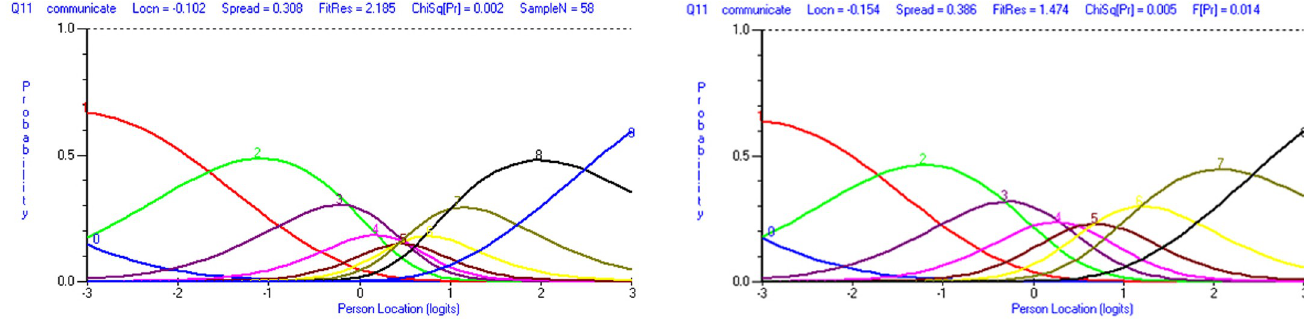
Fig 2. Category probability curves for item 11 (communicate results in a timely and sensitive manner) before and after rescoring response options. In panel 2a, category probability curves for item 11 show disordered thresholds. The x-axis is the construct, with the degree of compassionate care increasing from left to right. The y-axis shows the probability of endorsing the response categories 0 to 9 (10 response options in total). In panel 2b, category probability curves for item 11 show ordered thresholds after collapsing two adjacent response options together. The x-axis is the construct, with the degree of compassionate care increasing from left to right. The y-axis shows the probability of endorsing the response categories 0 to 8 (9 response options in total).